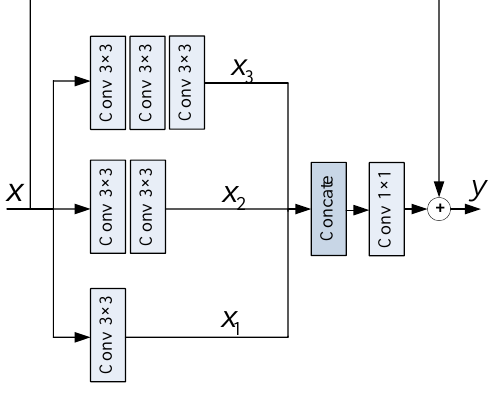
Figure 4. The structure of Multi-Scale Residual Block.